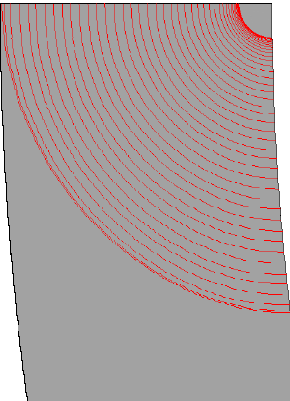
Figure 12: Detail of crack path.